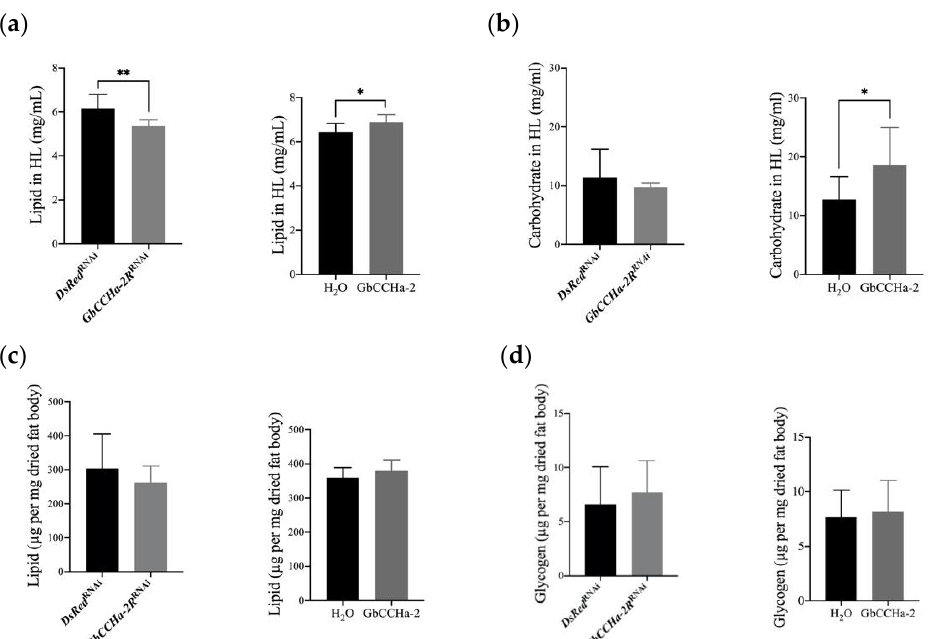
Figure 4. Effects of GbCCHa-2 signaling on the levels of lipids and carbohydrates in the hemolymph and fat body. ( a , b ) The levels of lipid ( a ) and free carbohydrates ( b ) in the hemolymph after GbCCHa- 2R knockdown and GbCCHa-2 administration. ( c , d ) The levels of lipid ( c ) and glycogen ( d ) in fat body. Values are showed as mean + S.D., n = 5 – 9, * p < 0.05, ** p < 0.01, unpaired t -test.